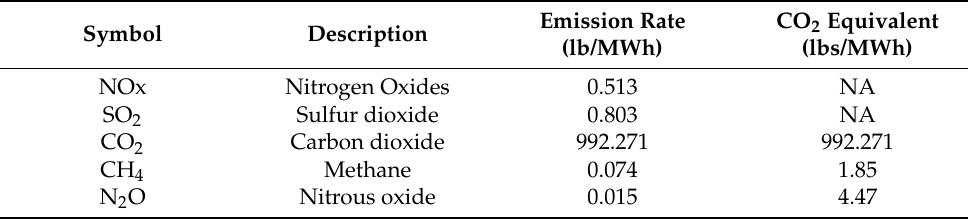
Table 5. Conversion factors from energy to emission type defined by EPA’s eGRID